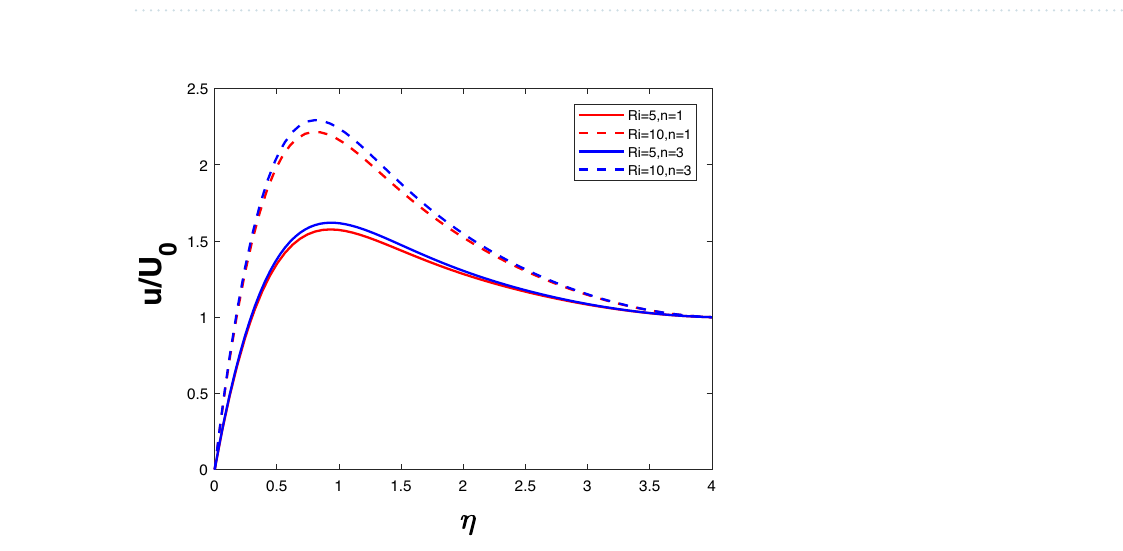
Figure 2. Velocity profile for various K .